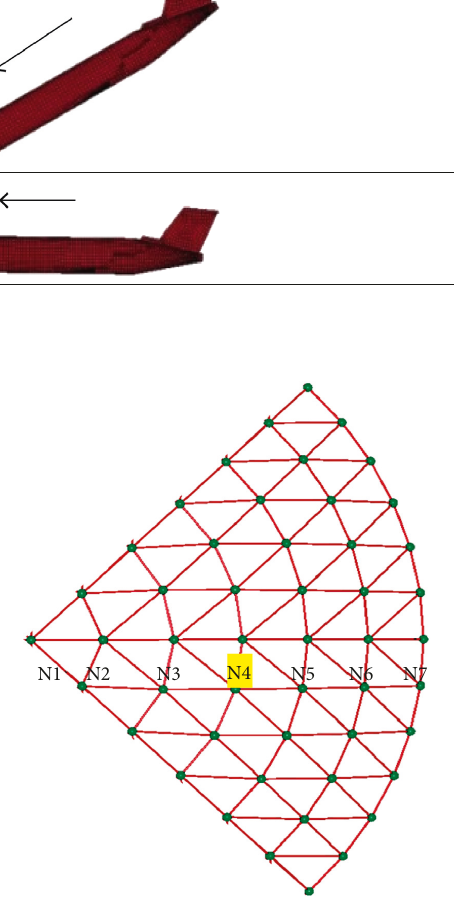
Figure 7: Serial number of nodes in the reticulated